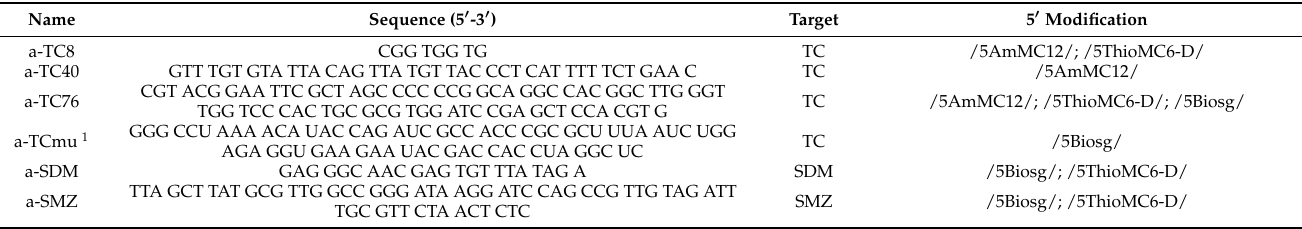
Table 1. List of aptamers tested. Aptamers were all DNA based, except for a-TCmu, which was RNA based. They were purchased without modifications or with one of the modifications listed in the last column. Some aptamers were also modified at the 3 (cid:48) end with a fluorescent label (/36-TAMSp/). All modifications are referred to the standard nomenclature of the manufacturer. TC: tetracycline; SDM: sulfadimethoxine; SMZ: sulfamethazine.